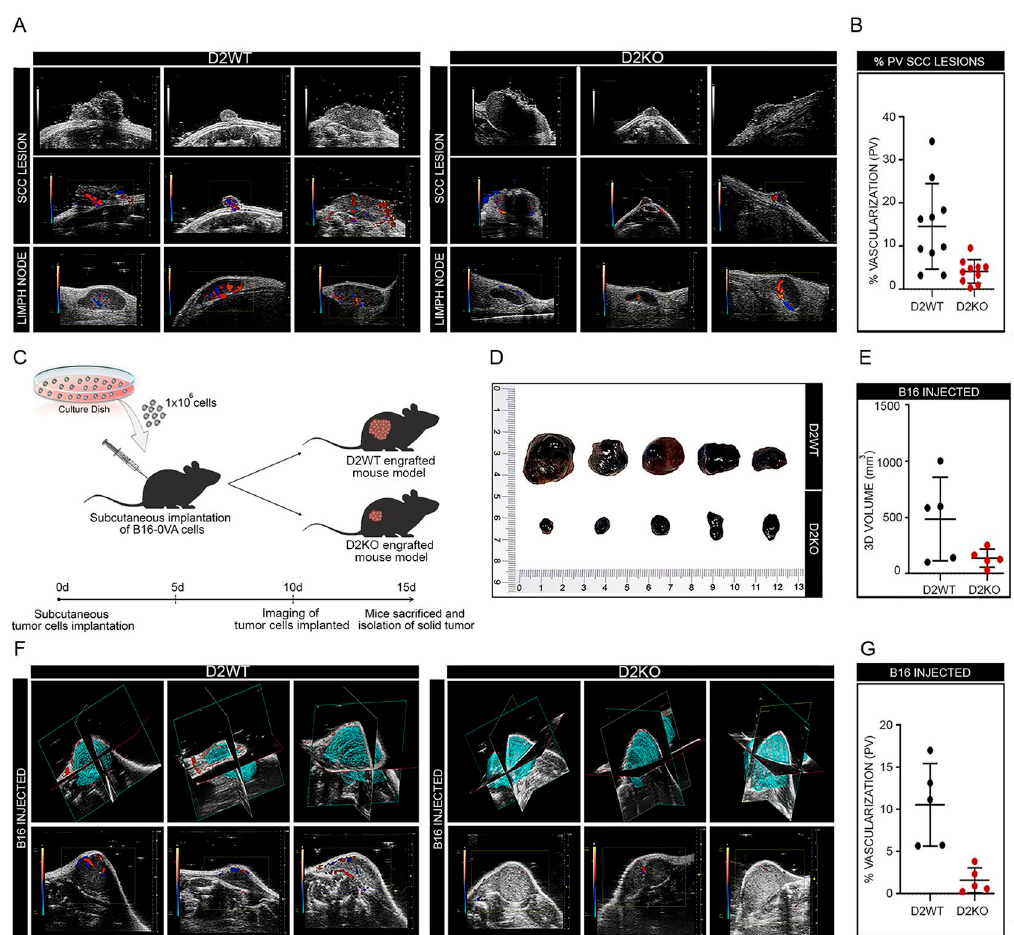
Figure 3. Attenuation of the TH signal drastically affects tumor vascularization and angiogenesis. ( A ) Color/power Doppler of dorsal skin lesions and axillar/inguinal lymph nodes from D2WT ( n = 10) and sD2KO ( n = 10) mice treated with DMBA/TPA to evaluate the tumor perfusion. ( B ) Relative quantification of skin lesion vascularization is represented by diagrams. ( C ) Global D2KO mice and D2WT mice were engrafted subcutaneously with 1 × 10 6 B16-OVA cancer cells (day 0); vascularization and growth of the tumor cells implanted were analyzed. Solid tumors were dissected 15 days after implantation of cancer cells and photographed ( D ); 3D volume (mm 3 ) of solid tumors derived from D2WT and D2KO mouse models ( E ) and angiogenesis of solid tumors were evaluated by Color/Power doppler analysis ( F , G ).